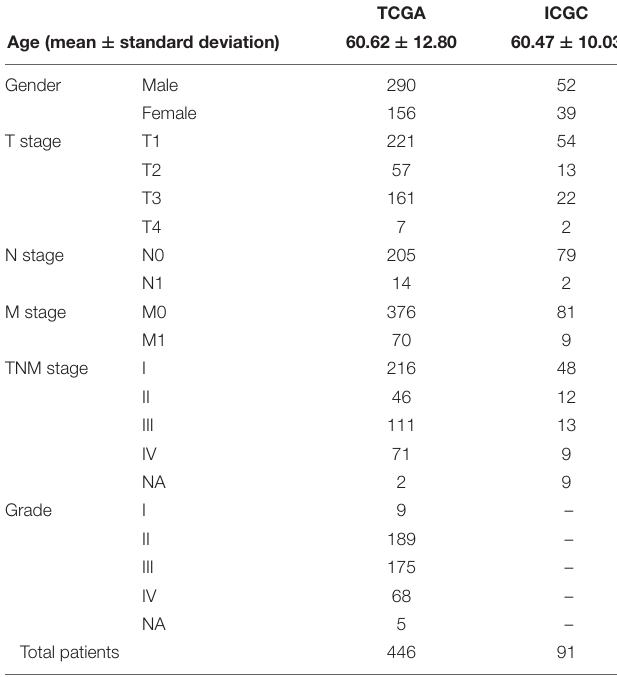
TABLE 1 | Information on patients included in this study.